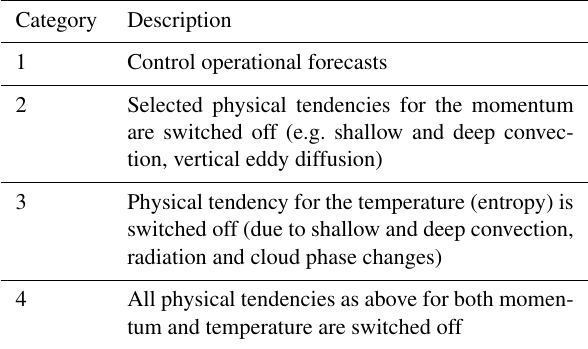
Table 1. Four major categories of